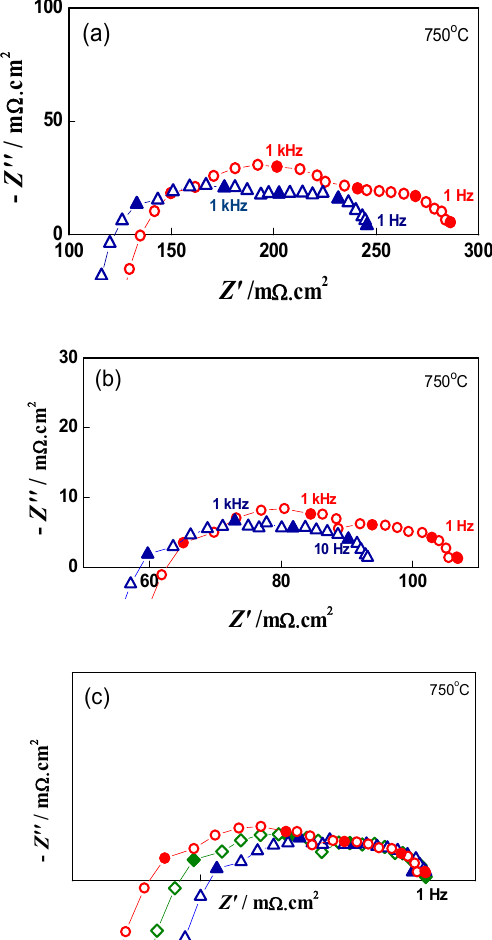
Figure 12. Impedance diagrams of button cell before Redox cycling ( ∆ ), after 7 Redox cycles ( □ ) and after 20 Redox cycles ( ○ ) under load of: ( a ) 0.28 A.cm −2 ; ( b ) 0.50 A.cm −2 ; ( c ) Normalized impedance data (0.50 A.cm −2 ) towards 1 Hz.